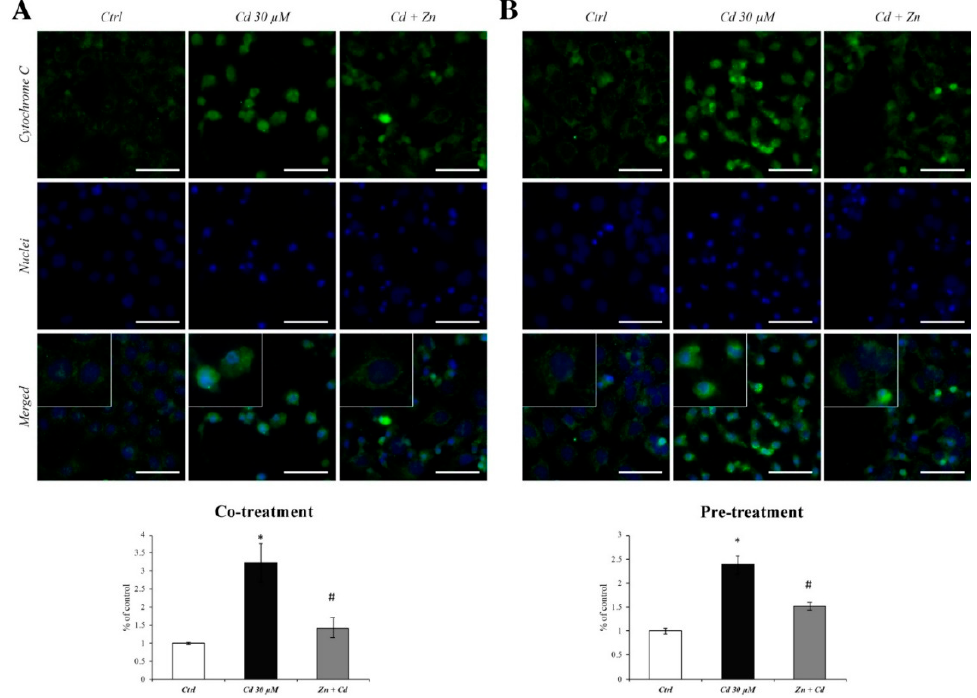
Figure 3. Cytochrome C expression after CdCl 2 and ZnCl 2 exposure. immunofluorescence stain- ing analysis of cytochrome C (green) during Zn cotreatment ( A ) and 24 h pretreatment ( B ). The semiquantitative analysis of fluorescence levels clearly showed a notable increase in cytochrome C in Cd 30 µ M treated cells (black bars), which was counteracted both during co- and pretreatment with Zn 50 µ M (grey bars). The inserts, at higher magnification, show the subcellular localisation of cytochrome C in RBE4 cells treated with Cd alone (Cd 30 µ M columns) or with the addition of Zn (Cd + Zn columns). Inserts show a punctate immunostaining pattern of cytochrome C under normal conditions, changing to a diffuse one after Cd treatment. Total magnification: 400 × and scale bar: 50 µ m. * p < 0.05 vs. Ctrl; # p < 0.05 vs. Cd